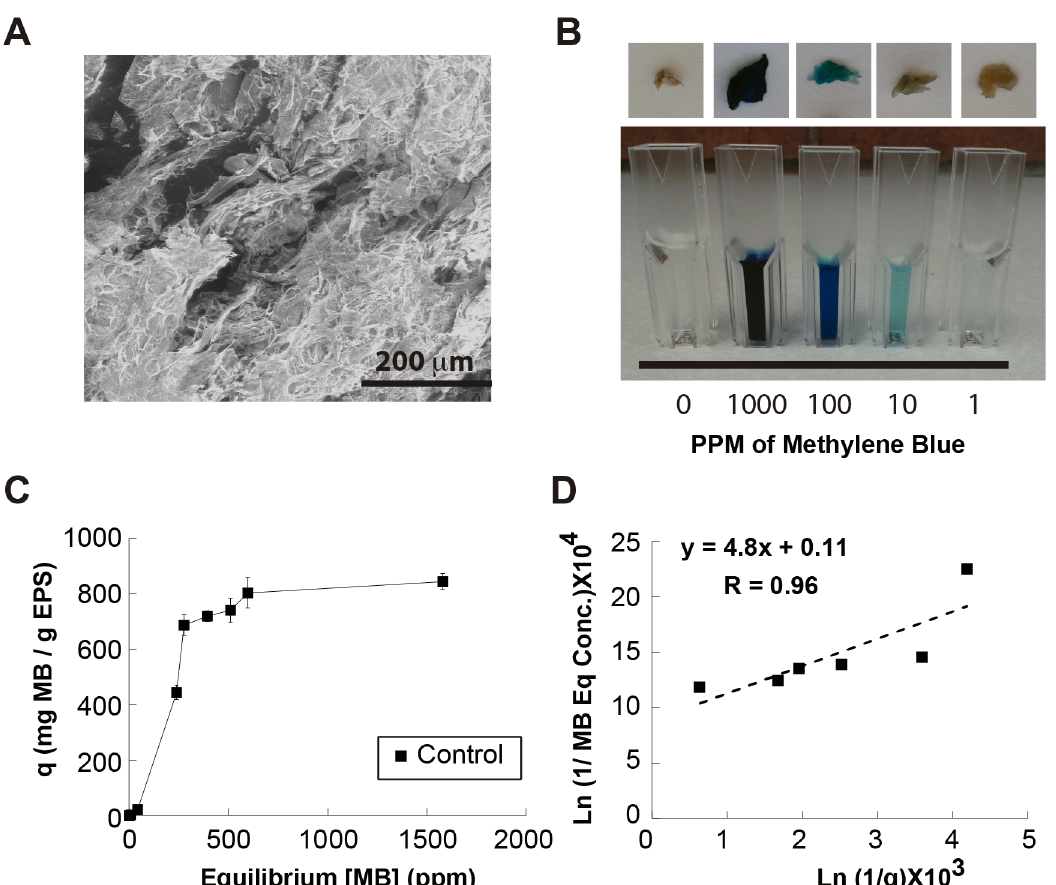
Fig 5. Bioadsorbent Properties of the EPS. A) SEM image showing morphology of EPS. B) Images of EPS after being stabilized for two hours with solutions of MB at different initial concentrations. C) Equilibrium MB concentration graphed against q (mg MB g -1 EPS) to obtain adsorption capacity of the EPS. D) Inverse of the q graphed against the inverse of the equilibrium MB concentration in solution in a logarithmic scale. The plot allows fitting to a straight line suggesting the adsorption behavior follows a Langmuir Isotherm.